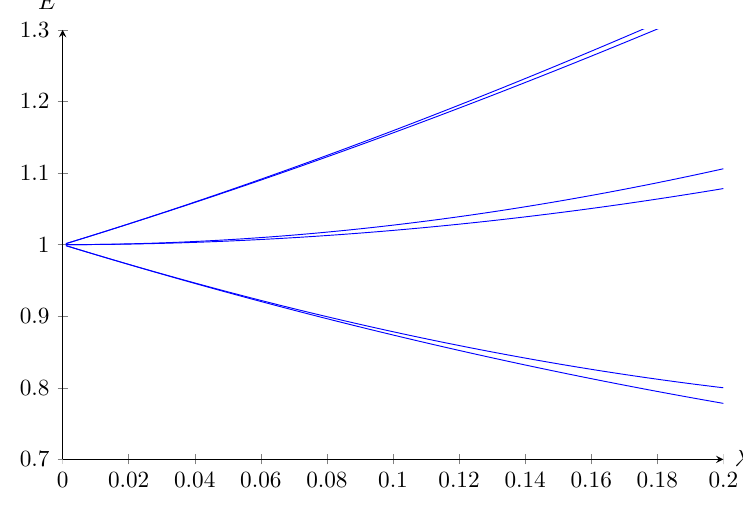
model for small λ for L = 14, f = 7, 2